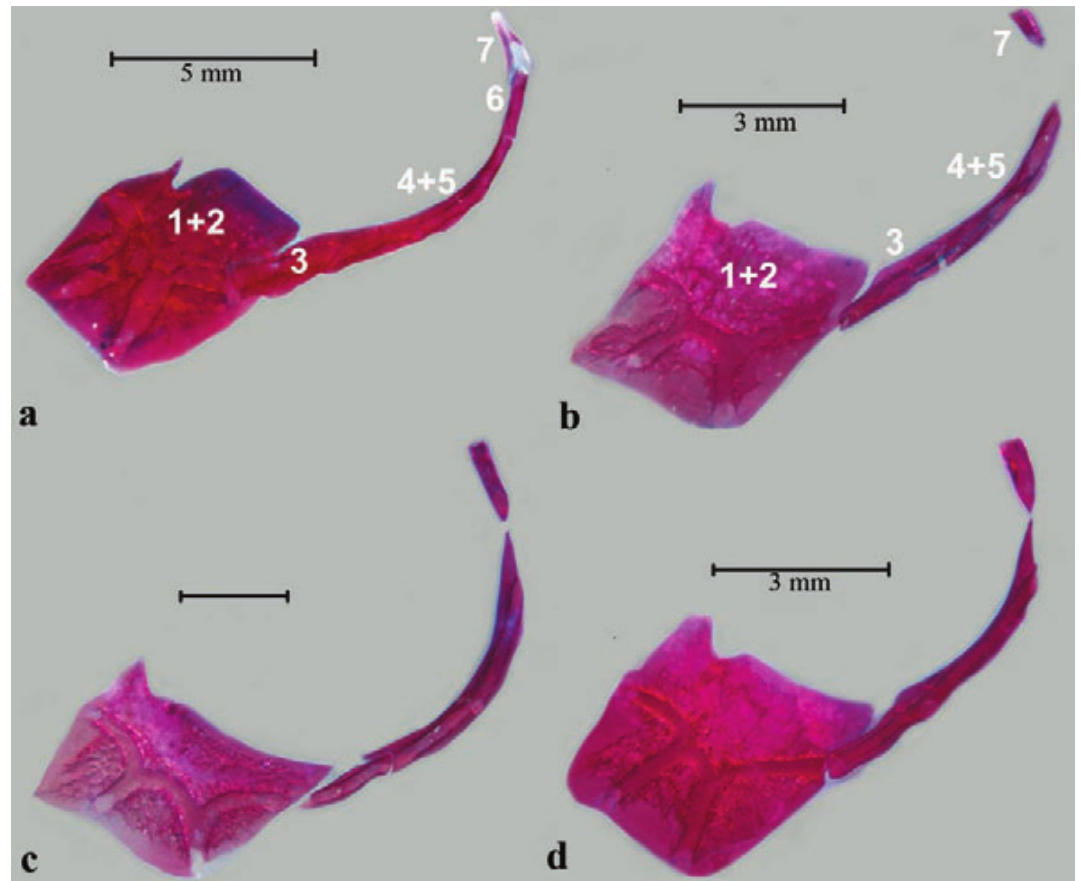
Fig. 2. Infraorbital series in left, lateral view, illustrating morphological character 116; a ) Guianacara dacrya , character state 116-1, paratype, 58.0 mm SL, ANSP 179495; b ) Mazarunia charadrica , character state 116-3, 56.0 mm SL, ROM 83808; c ) Mazarunia mazarunii , character state 116-3, 50.1 mm SL, ROM 83869 d ) Mazarunia pala , character state 116-3, 50.8 mm SL, ROM